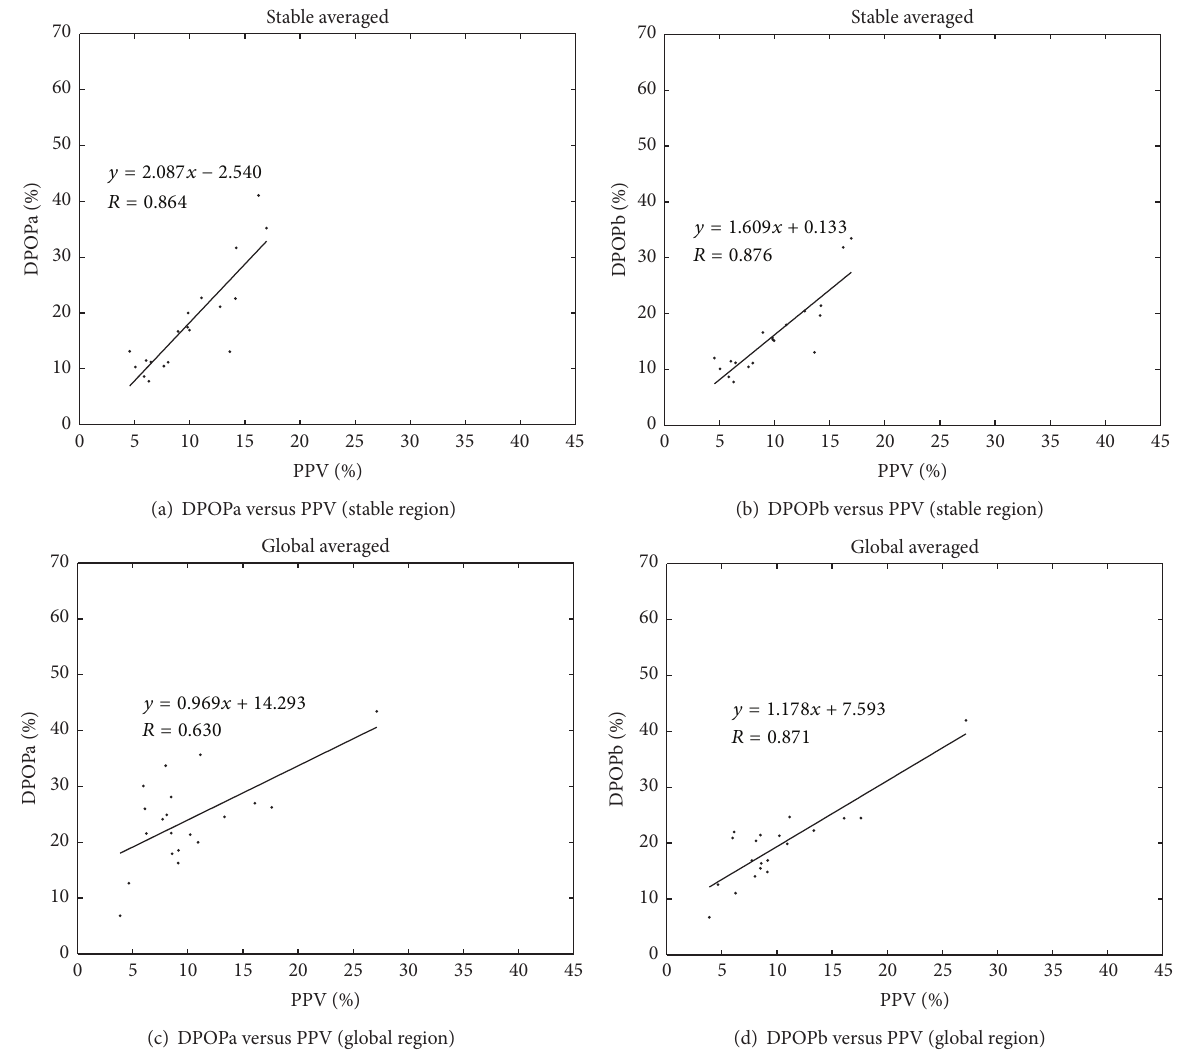
Figure 7: DPOP results reported on a one-point-per-patient